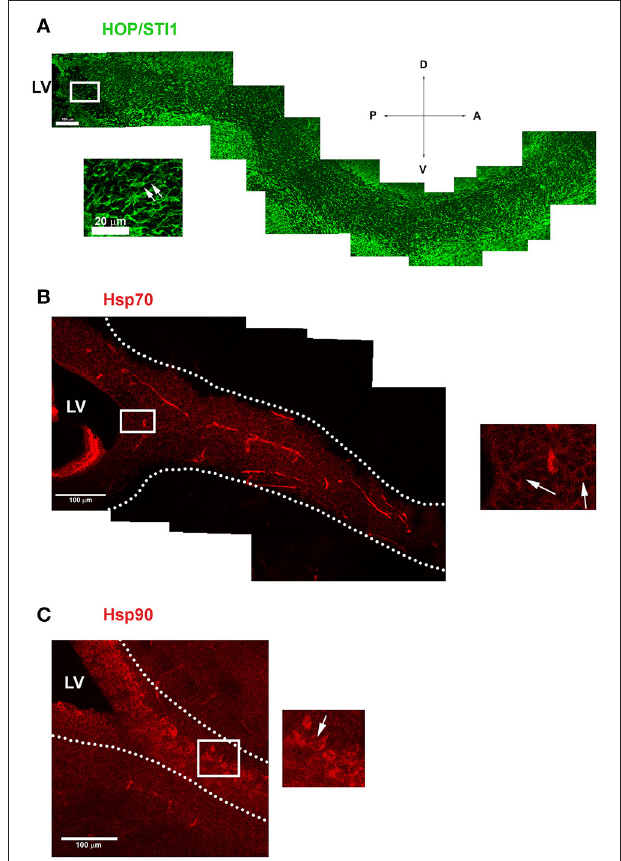
FIGURE 1 | Proteins from Hsp90 complex are expressed in the anterior subventricular zone and along the rostral migratory stream. (A) Image demonstrates HOP/STI1 expression extending from the anterior portion of the lateral ventricle (LV) toward the olfactory bulb along the rostral migratory stream (RMS). Inset shows cells with typical migratory morphology in the vicinity of LV expressing HOP/STI1 (arrows). (B,C) Hsp70 and Hsp90 also exhibits a periventricular expression which continues along the RMS (delimited by dotted lines) In the insets, individual cells expressing these proteins can be visualized in the vicinity of the lateral ventricle (B) and along the RMS (C) (arrows). Scale bar: A(100 µ m), inset of (A) 20 µ m (B,C) 100 µ m. LV-Lateral Ventricle. Wind Rose–D, Dorsal; V, Ventral; A, Anterior; P, Posterior.